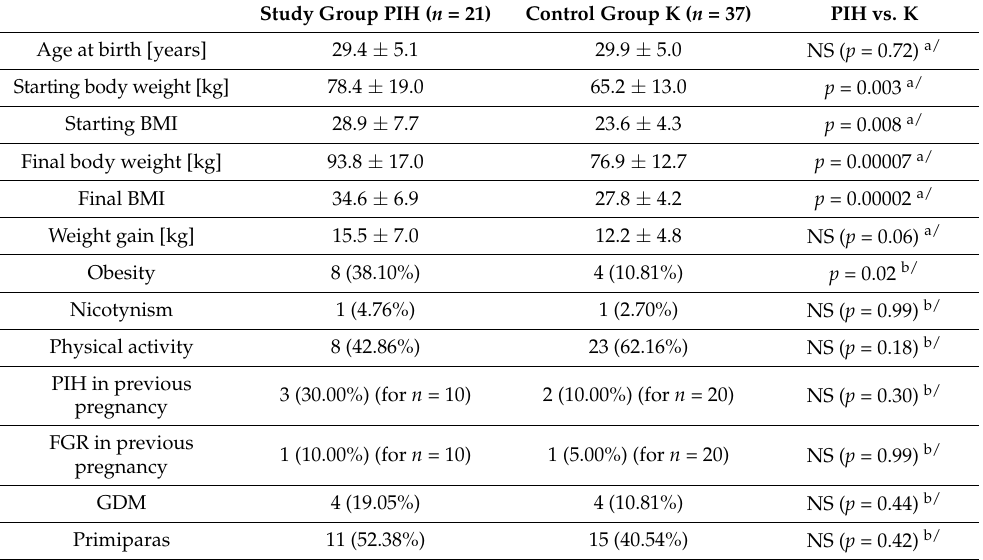
Table 1. Group characteristics ( a/ Student’s t -test; b/ Fisher’s exact